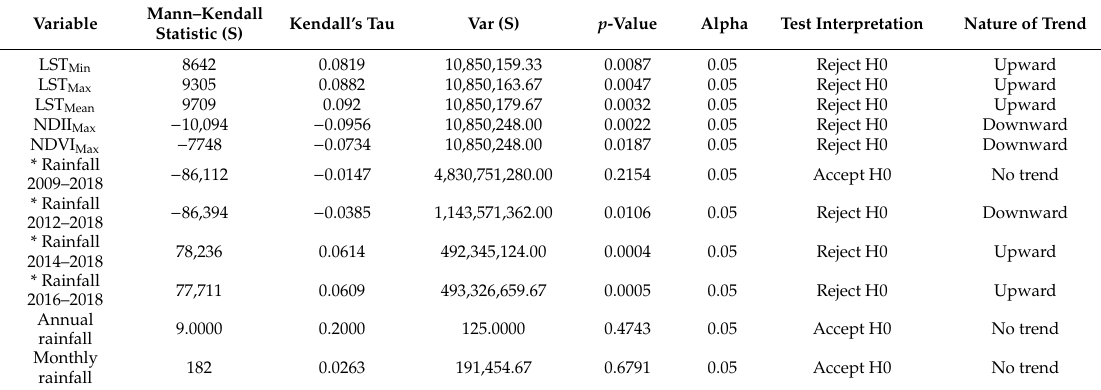
Table 7. Mann–Kendall trends test results for variables with abrupt change points.